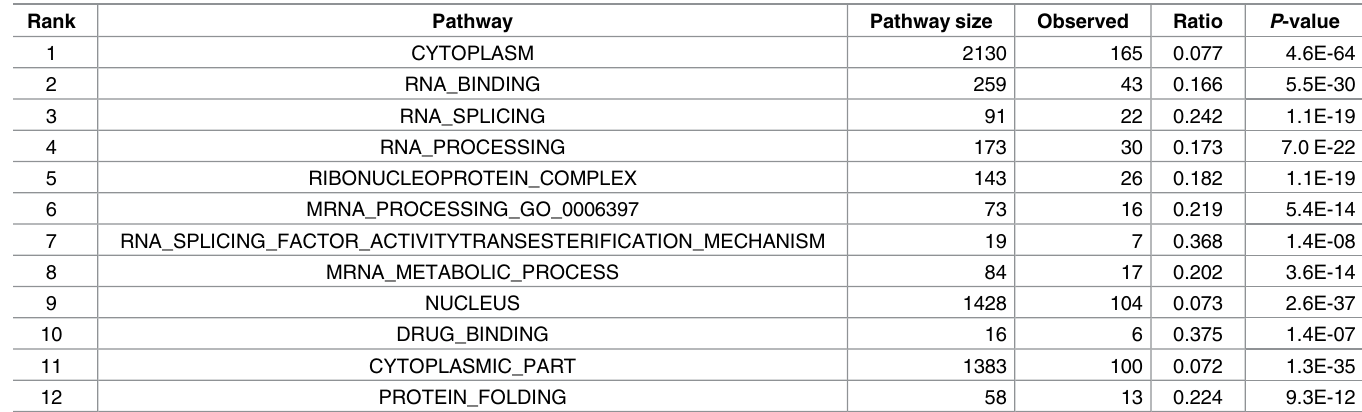
Table 1. Top-ranked pathways by GO analysis.